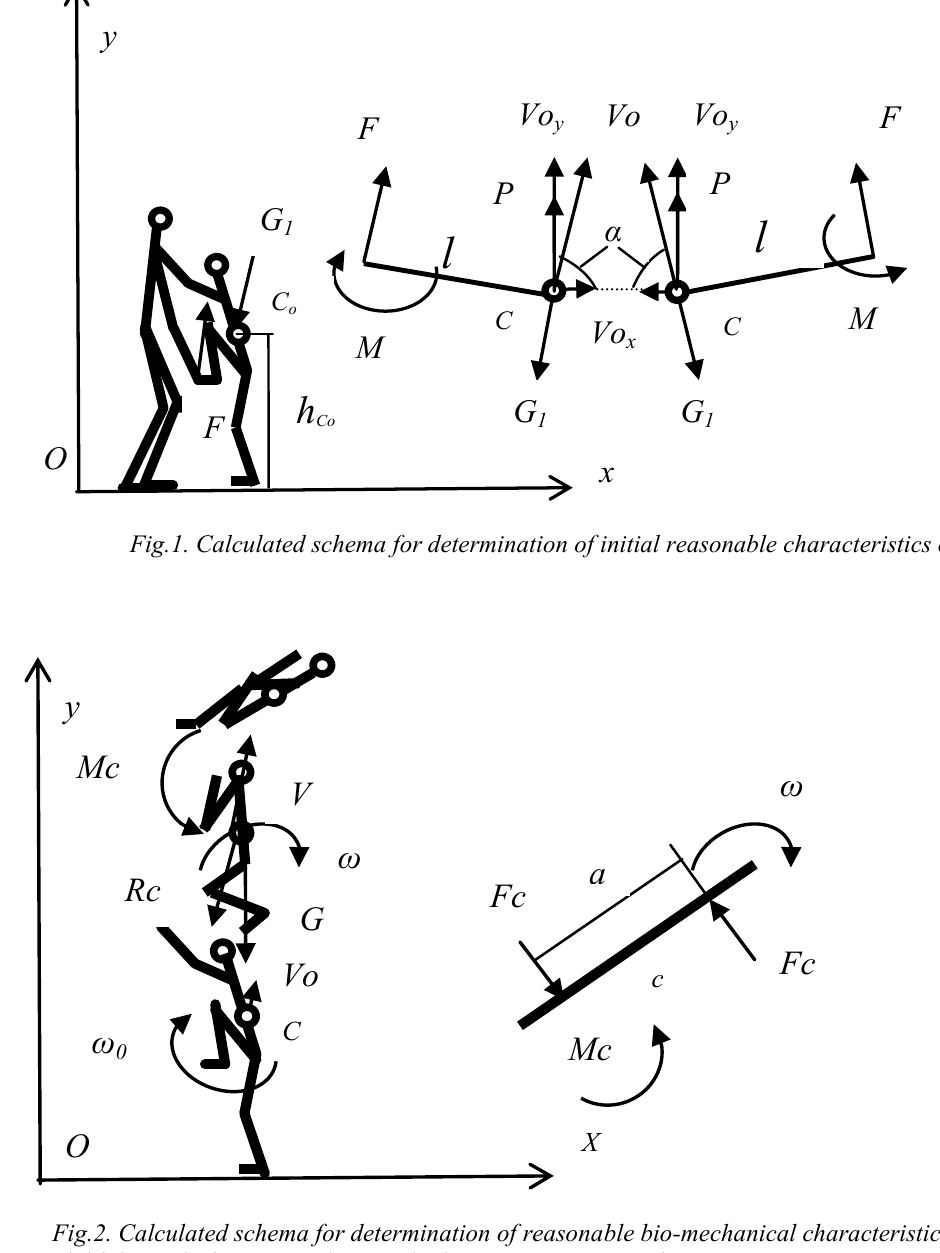
Fig.2. Calculated schema for determination of reasonable bio-mechanical characteristics in flight phase V 0 - initial speed of sportsman/woman body masses center’s rush out, Vо X – projection of body masses center’s rush out speed on axis Ox